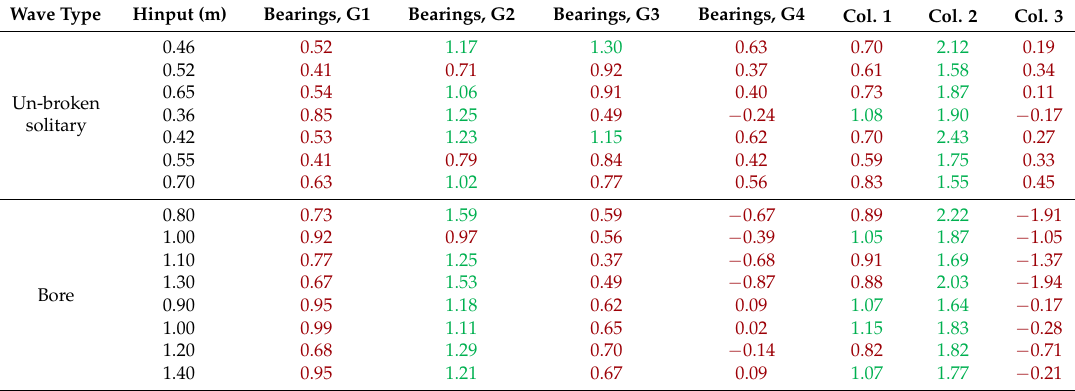
Table 3. Ratio of bearing and column-bent cap connection uplift forces calculated from the simplified method to the respective values recorded in the experiments.